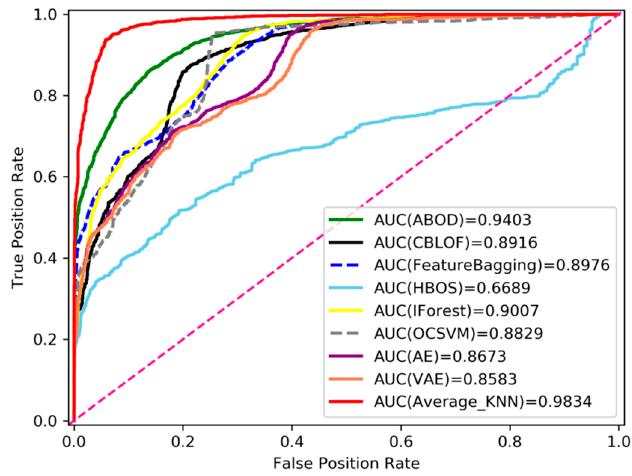
Figure 9. Comparison of anomaly detection algorithms based on the AUC index. Table 3. Comparison of each anomaly detection algorithm based on precision and time index.